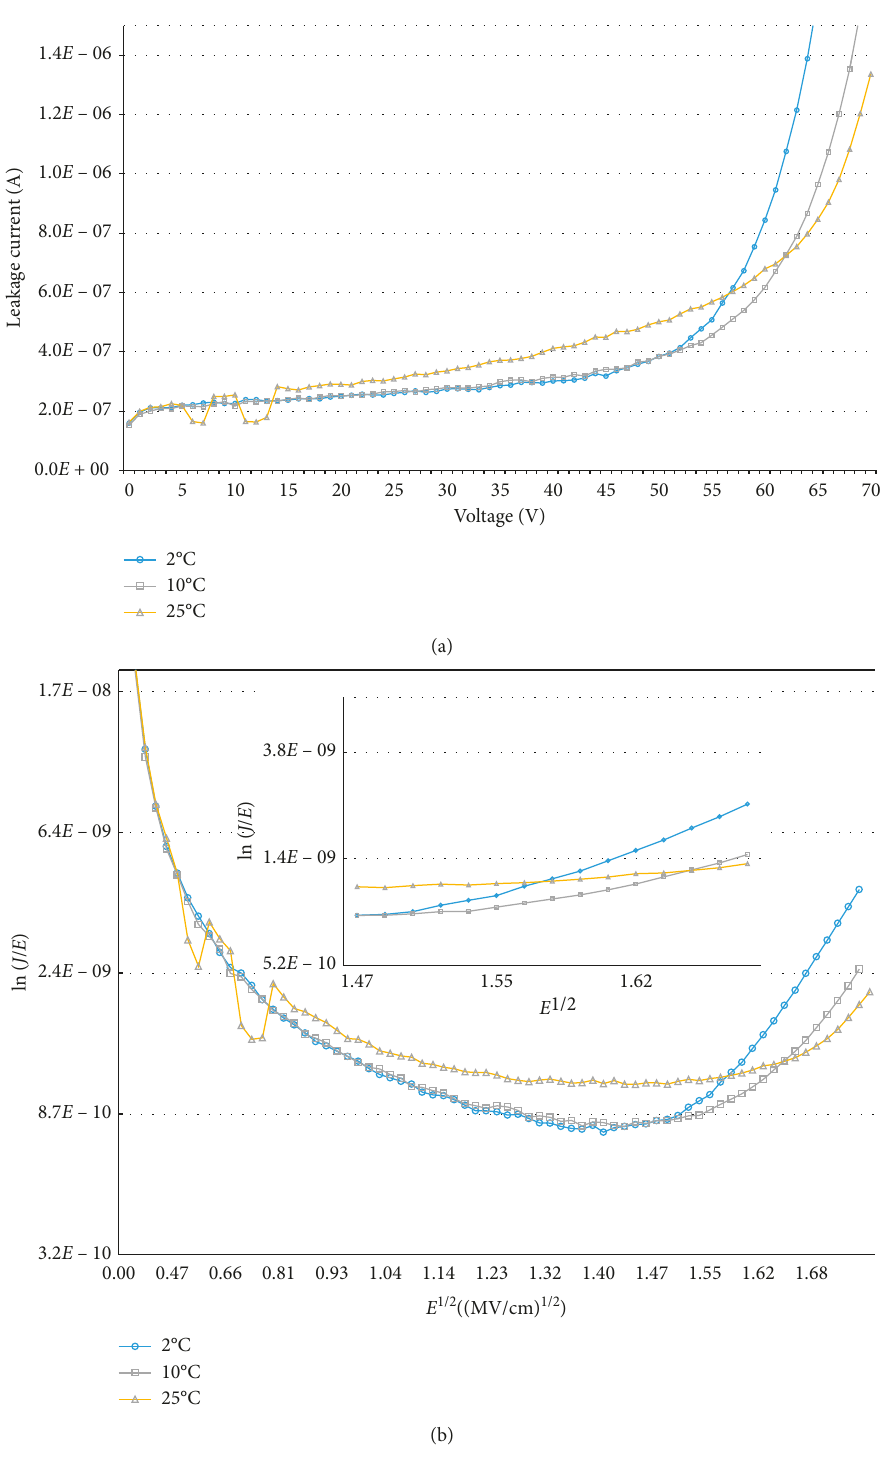
Figure 6: PF emission saturation observed in 35V 22 μ F chip tantalum capacitors at temperature range within 25 ° C. (a) I - V plots and (b) PF plots (ln J / E − E 1/2